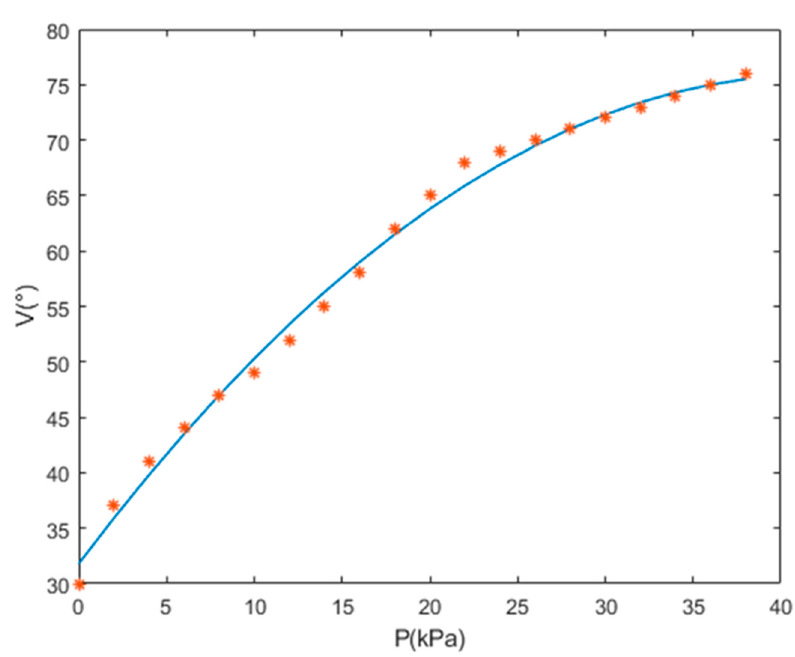
Figure 22. VSICE FOV curve, where V is half the FOV of VSICE.